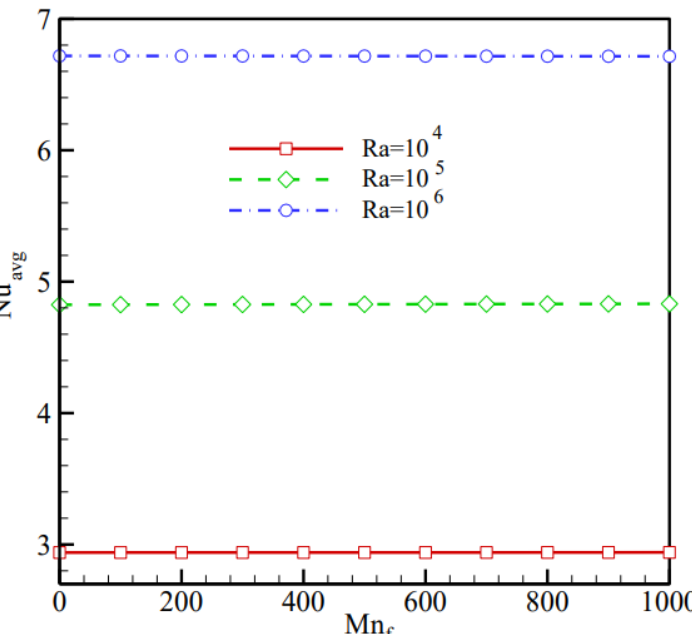
Figure 6. Variation of Nusselt number with the magnetic number for various values of Rayleigh number. Reprinted with permission from Ref. [20]. 2019, Elsevier.